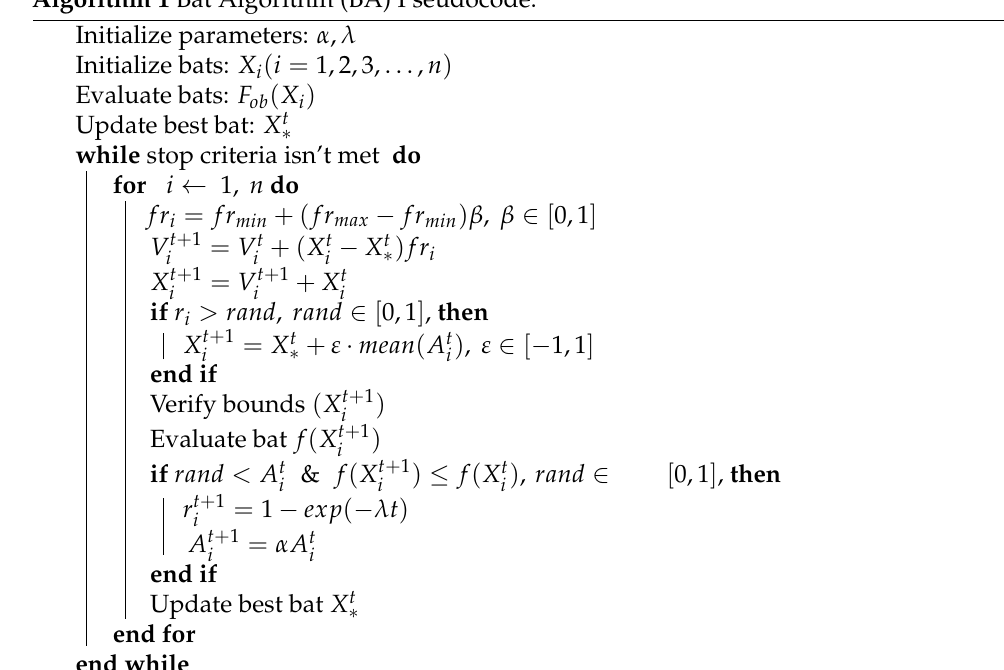
Algorithm 1 Bat Algorithm (BA)